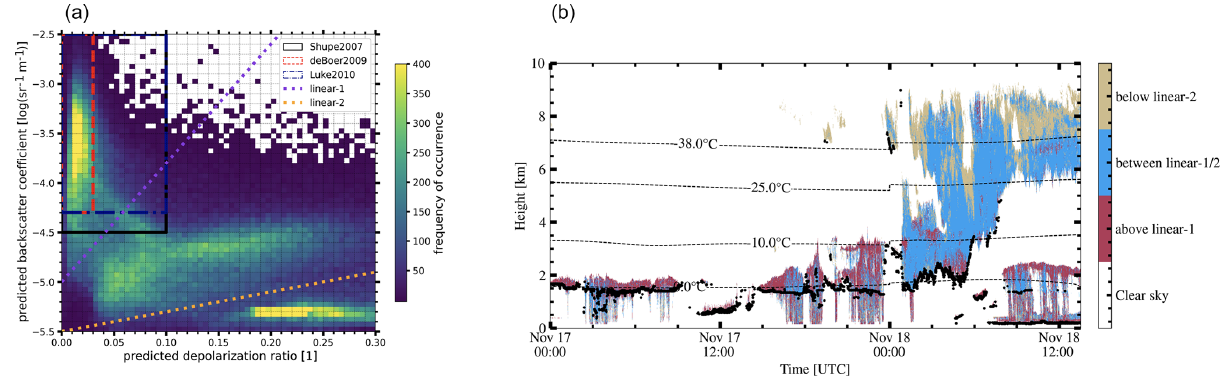
Figure 2. (a) Frequency of occurrence of ANN-predicted lidar backscatter coefficient β vs. predicted lidar linear depolarization δ for the 17–18 November 2014 case study. (b) Time–height mapping of predicted β and δ of the three corresponding areas in the (a) panel, which are separated by the two linear thresholds. Black dots (b) indicate the ceilometer cloud base